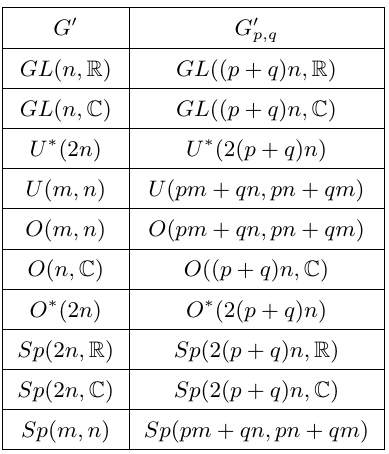
for each irreducible G 0 p;q